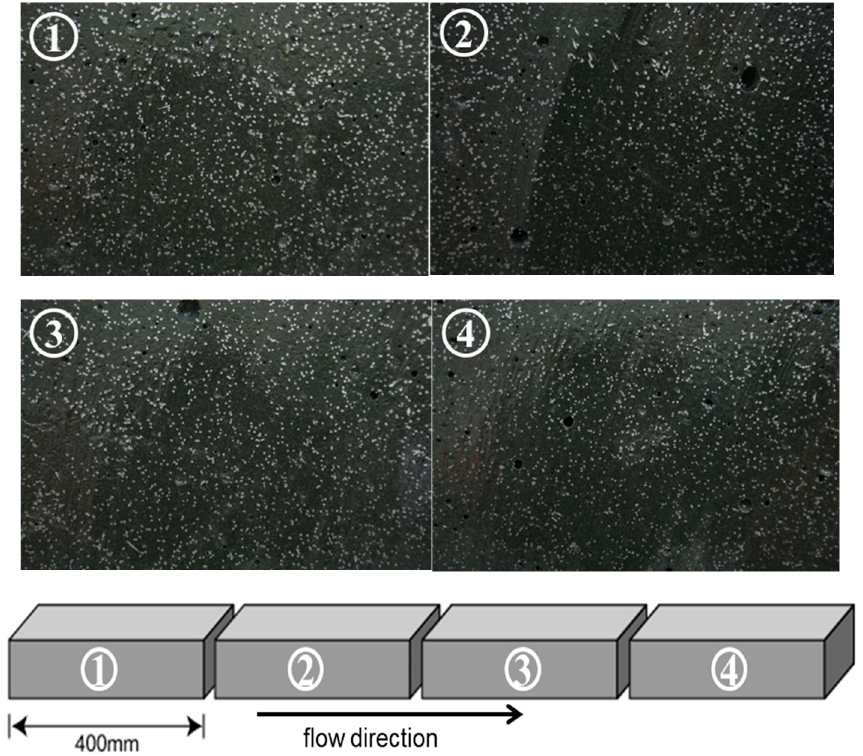
( b ) Figure 7. Load-CMOD curves obtained from experiments; ( a ) from beam 1; and ( b ) from beam 2. 5. Analysis and Comparison First, the fiber orientation distribution near the fractured surface in the beam test was investigated in order to examine the relation between the fiber orientation and the flexural behavior. For the purpose, the specimens after finishing the flexural test were cut along a plane near to the fractured plane induced by notch, and sectional images of the cut planes were obtained. Figure 8 presents the fiber distributions observed at the cut sections of beam 1. Similar to the results of the flexural test, it could be found that there was no noticeable difference in the fiber orientation distribution. For quantitative evaluation of the fiber orientation distribution, the number of fibers detected in the cut section was counted using an image analysis technique. It may be better if the fiber orientation distribution could be measured directly from the image analysis, but due to the relatively